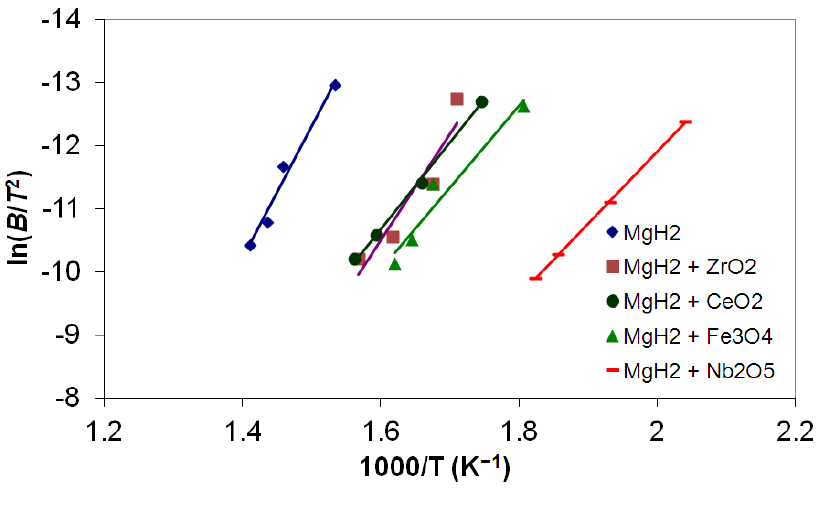
and catalyzed MgH 2